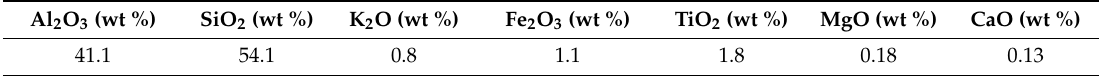
Table 1. Chemical composition of Metakaolin Mefisto L05.